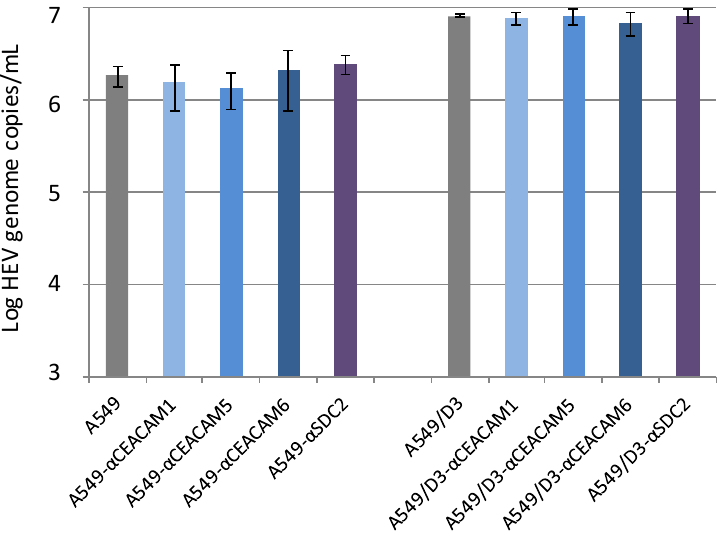
Figure 5. Effect of treatment of cells with carcinoembryonic antigen-related cell adhesion molecule ( CEACAM)- and syndecan 2 (SDC2)-specific antibodies on the replication of HEV strain 47832c. A459 cells and A549/D3 cells were incubated with or without CEACAM1-, 5-, 6- and SDC2-specific antisera prior and after HEV inoculation. The HEV genome copy number present in the culture supernatant at 14 days after infection and the standard deviation (error bars) of three replicates each are shown.